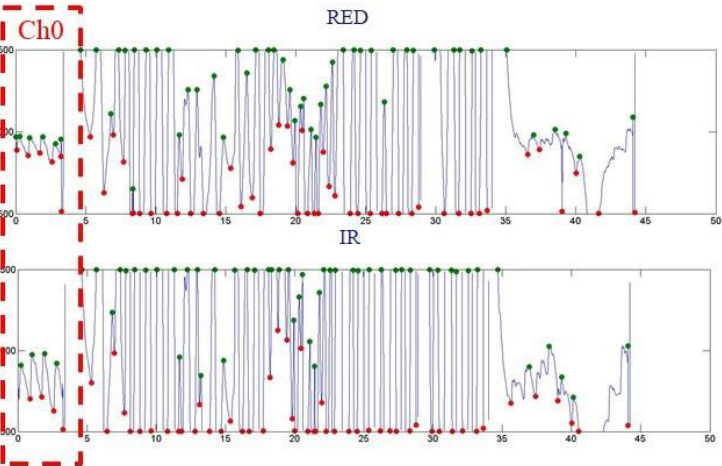
Figure 15. Dynamic state of the blood oxygen concentration value measurement results of a flexible blood oxygen sensing array with a pitch of 7 mm.